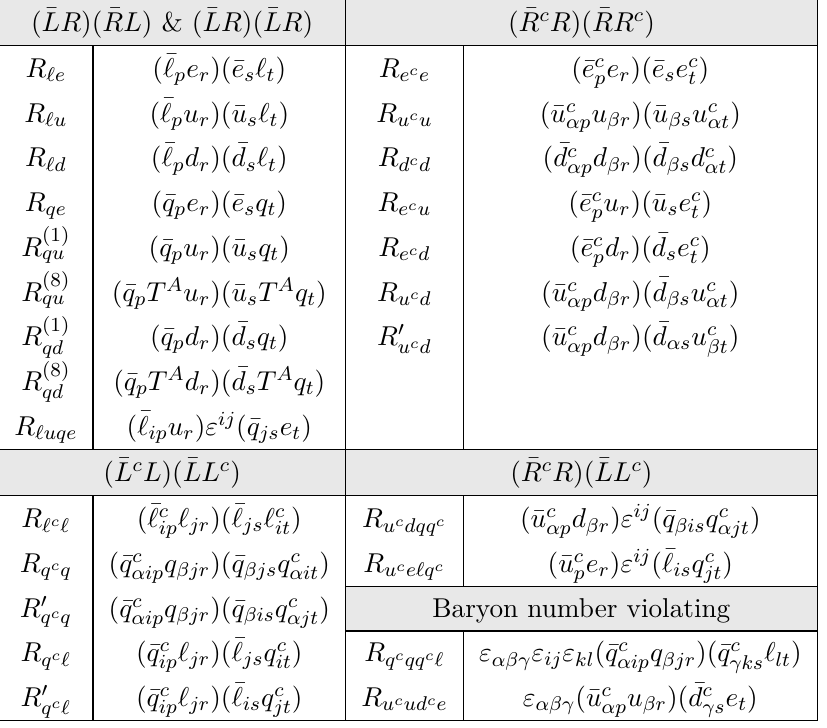
Table 1. Scalar-type four-fermion operators that are redundant in d = 4